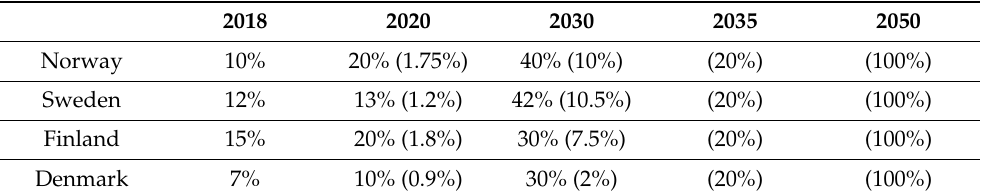
Table 4. Blending requirements in road traffic by country. Assumed forest-based share of total in